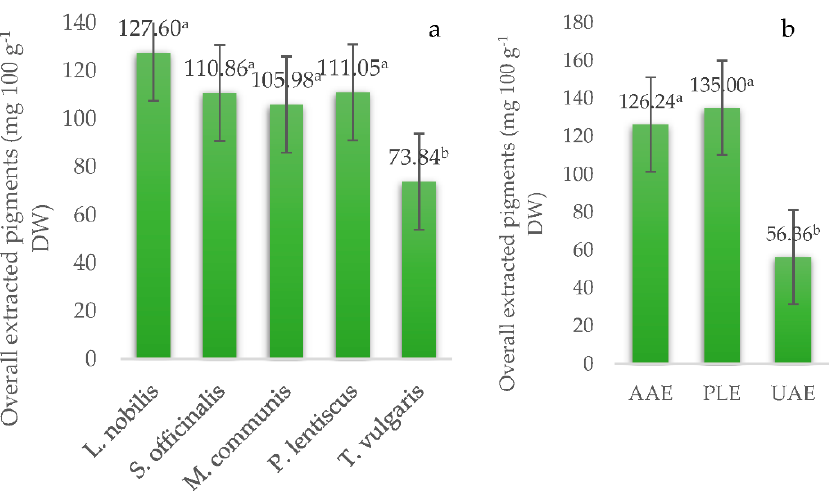
Figure 2. Overall extracted pigments, as determined by the HPLC-DAD method (mg 100 g − 1 DW), in the extracts of selected Mediterranean herbs, affected by herb species ( a ) and extraction method ( b ). AAE = agitation-assisted extraction, PLE = pressurized liquid extraction, UAE = ultrasound-assisted extraction. Results are shown as mean and SE (error bar). Different letters indicate significant differences, according to Tukey’s test at p ≤